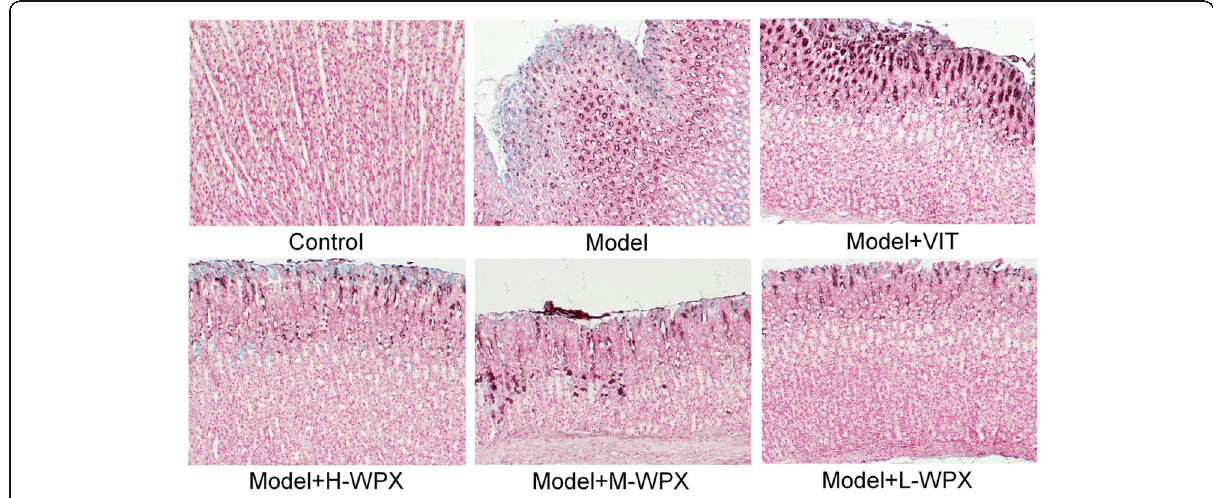
Fig. 2 Histological evaluation of gastric intestinal metaplasia. Neutral mucins present in normal mucosa were stained red. Sialomucins expressed only in small intestinal-type metaplasia (S-IM) were stained blue, and sulfomucins present in colonic-type metaplasia (C-IM) were stained brown. Images of model gastric epithelium depicted prominent S-IM and C-IM lesions, which were dramatically reduced after WPX administration. n = 9 in each group. (HID-AB-PAS staining,